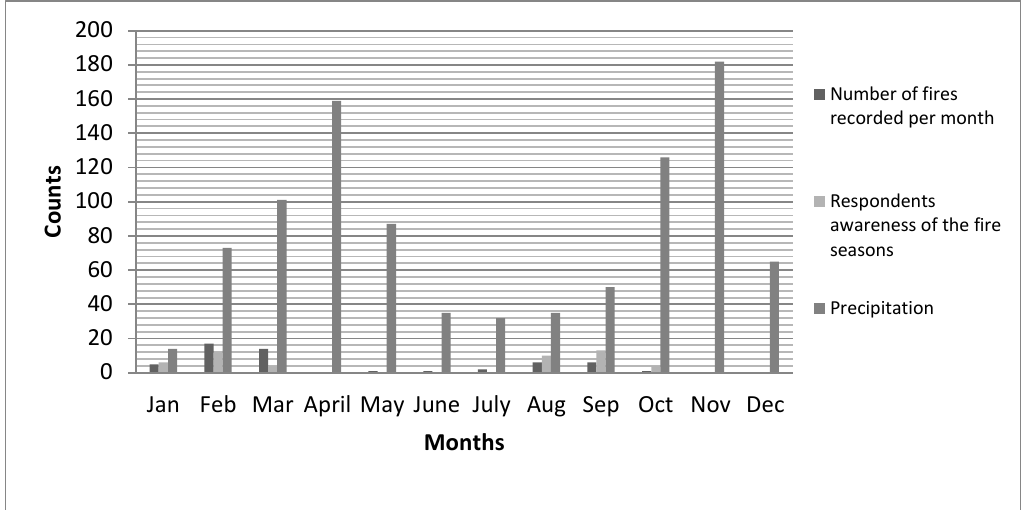
Figure 4. Precipitation, the number of fires recorded by KFS and the fire seasons in Gathiuru Forest based on the perceptions of the local people (N =